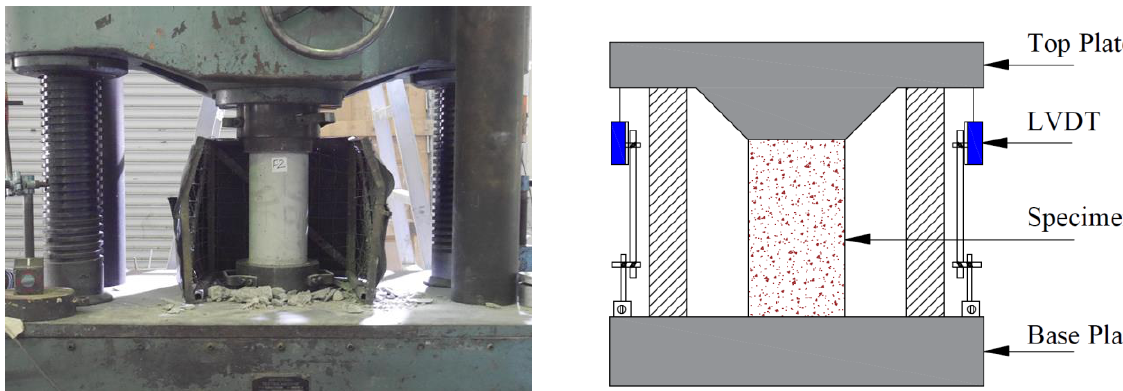
Figure 6. Mechanical testing setup.